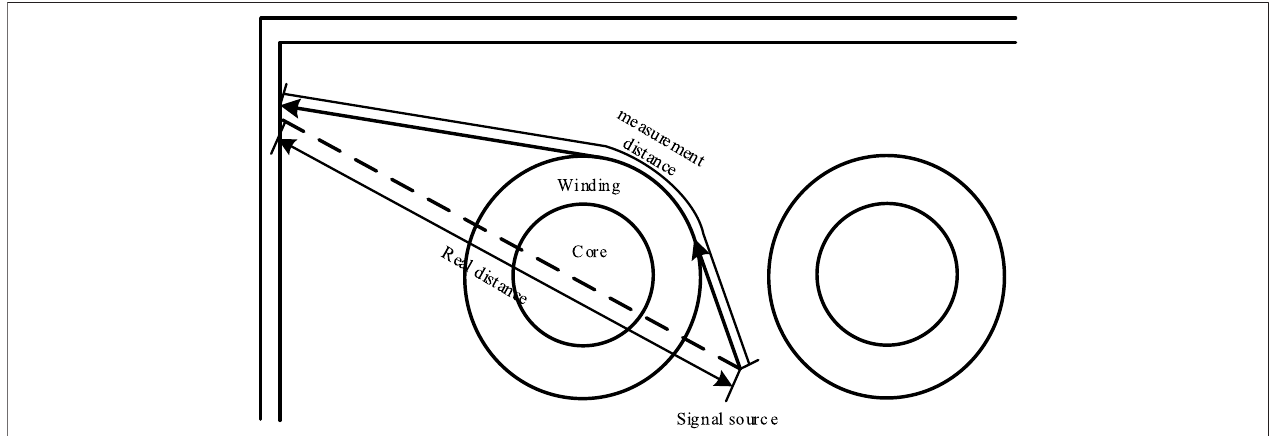
FIGURE 2 | Diagram of the relationship between measurement distance and real